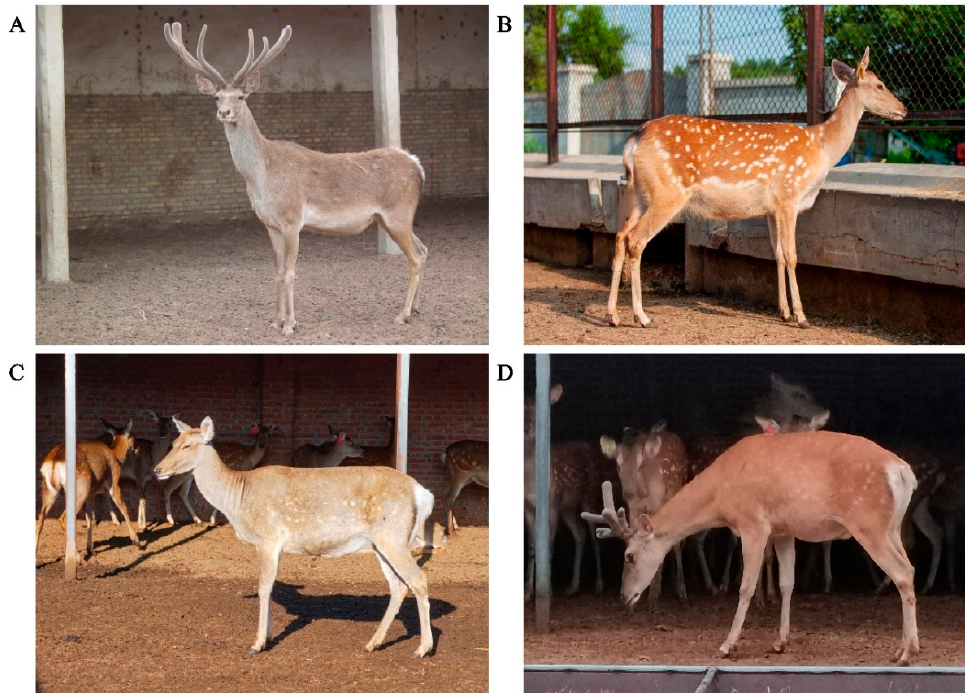
Figure 2. Appearance of F1s and their parents: ( A ) male red deer and ( B ) female sika deer; ( C , D ) F1